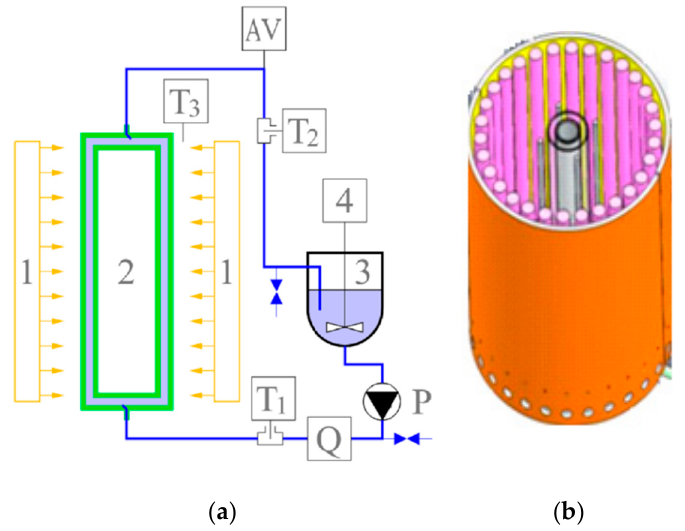
Figure 2. Functional scheme of the photo-reactor ( a ) and detail of the cylindrical quartz tube inside the lighting system ( b ). 1—LEDs and UV lamps; 2—Cylindrical quartz tube; 3—Storage tank; 4—Electric overhead stirrer; AV—Air vent; P—Hydraulic pump; Q—Flowmeter; T1—Inlet temperature sensor; T2—Outlet temperature sensor; T3—Ambient air temperature sensor